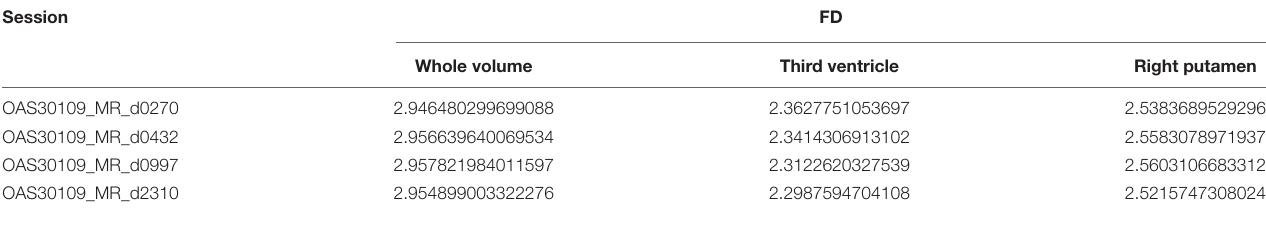
TABLE 4 | Box-counting FD testing on multiple sessions of the same subject OAS30109.